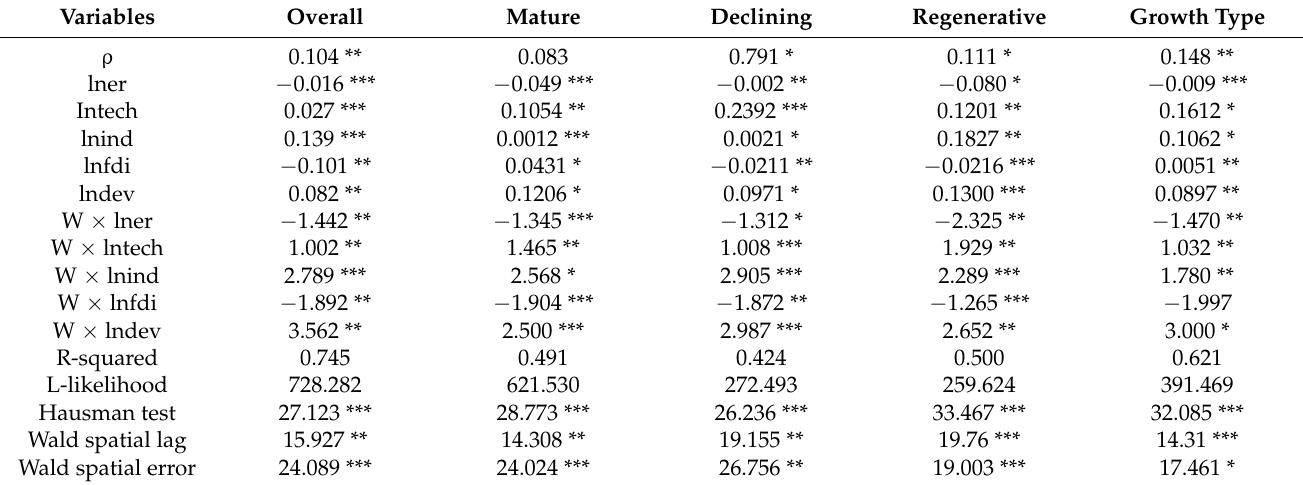
Table 8. Empirical results of influence factors of resource-based